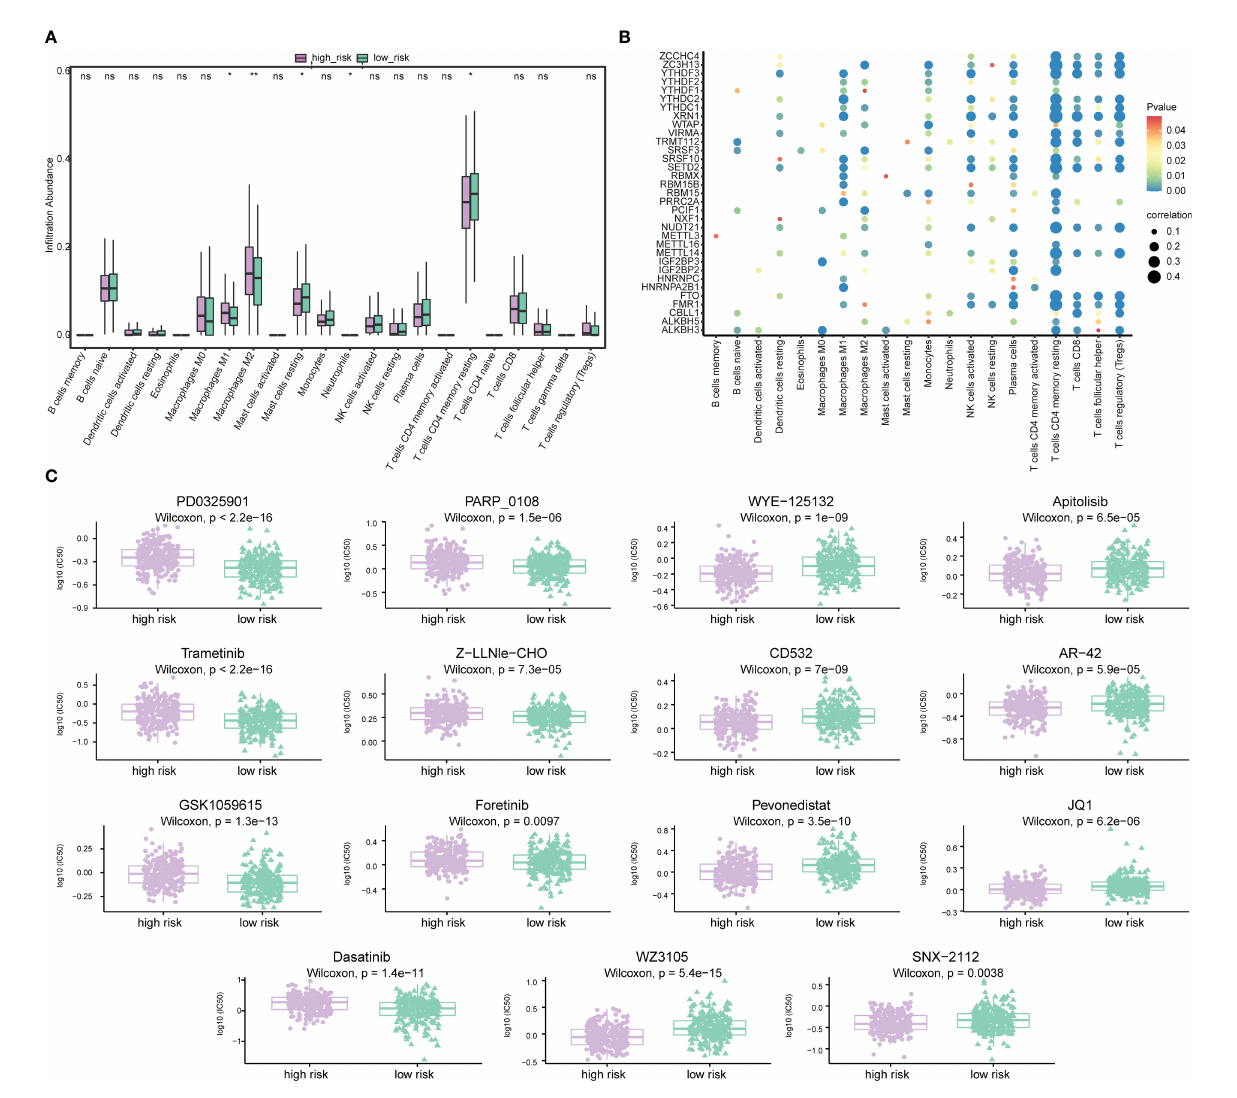
FIGURE 12 Association of risk score-m 6 A-related gene-immune cell in fi ltration and drug sensitivity. (A) Histogram of the level of immune cells in fi ltration between patients in a high-risk group and low-risk group. Light green represents the high-risk group, dark green represents the low-risk group, the horizontal axis represents immune cell subtypes, and the vertical axis represents the in fi ltration level of cells. (B) Correlation diagram between m 6 A- related genes and immune cells. The horizontal axis represents immune cell subtypes, the vertical axis represents m 6 A-related genes, the node size represents the absolute value of the correlation size, and the node color represents the signi fi cance level. (C) Differences in drug sensitivity between patients in the high-risk group and low-risk group. The horizontal axis indicates grouping, and the vertical axis indicates -log0 (IC50). *P < 0.05, **P < 0.01, ns, not signi fi